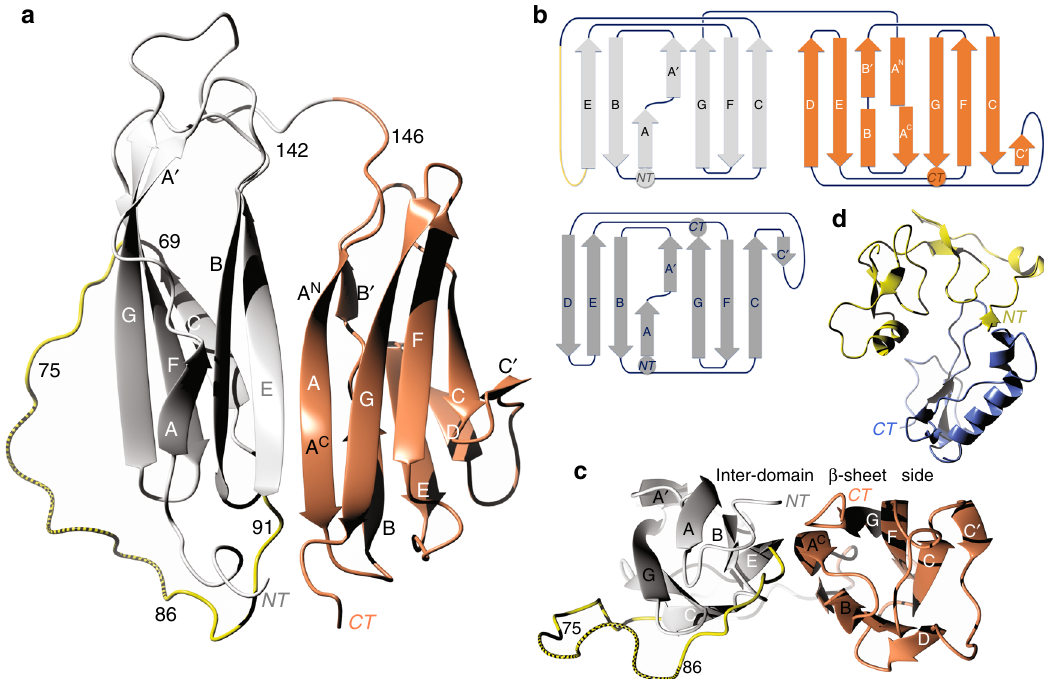
Fig. 3 Structure and fold of the apo Imp-L2 protein. a Ribbon representation of the apo Imp-L2 structure. The Ig-NT and Ig-CT domains are in white and coral, respectively. NT-terminal and CT-terminal of protein. This is a top representation of the Imp-L2 with the view on a large, continuous inter-domain β - sheet. Amino acids 142 – 146 constitute short domains-linking loop, and 70 – 92 a long Ig-NT loop (in yellow); 75 – 86 part of this loop is marked by dashed lines, as it was highly mobile in the apo-Imp-L2, and is not included in the fi nal model; it was traced here in a weak, non-re fi ned electron density for an overall clarity of this fi gure. b The folding scheme of the Imp-L2 (top) and a typical Ig-I type immunoglobulin fold (below Ig-NT scheme). The grey/coral colouring scheme corresponds to the Ig-NT and Ig-CT domains, respectively. The shift of the A N /A C parts of the A strand in the fold scheme of the Ig-CT domain represent a signi fi cant twist of this β -strand and split contribution of this strand to different β -sheets. c A view on the Imp-L2 from the N- and C- termini edge of this protein. d A representative structure of human IGFBP-4 (PDB ID: 2dsr); only the N-domain and C-domain are shown, and the IGF-1